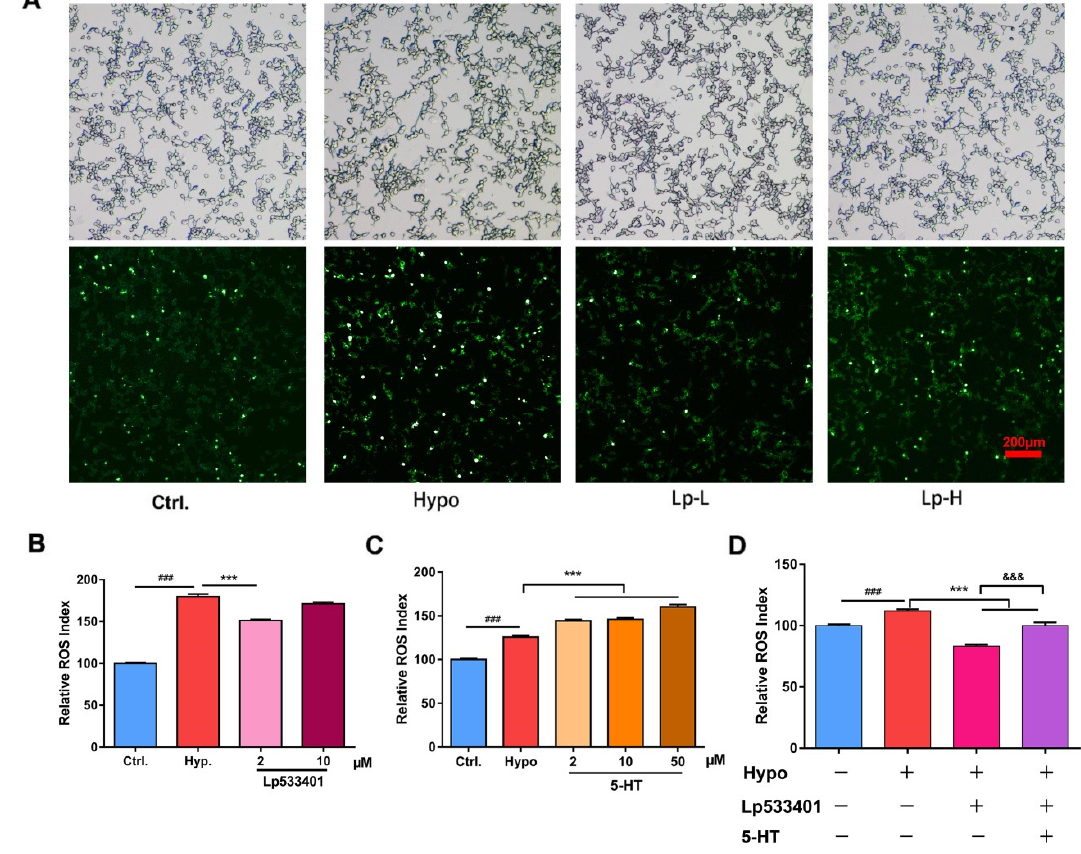
Figure 4. The 5-HT metabolism pathway influenced the ROS generation in RIN-14B cells. ( A ) Cells were stained with DCFH-DA and were observed under a fluorescence microscope. Representative fluorescence images showed the ROS level in RIN-14B cells compared to the control after exposure to 5% O 2 for 48 h. (Lp-L: 2 µ M, Lp-H: 10 µ M; Scale bar: 200 µ m). ROS were detected with ROS assay kit after treated with ( B ) LP533401, ( C ) 5-HT, and ( D ) both. "+", the sample treated with the corresponding condition or the agents at certain concentrations, and “ − ”, untreated. ( n = 6 each group). ### P < 0.001 represent compared with control, *** P < 0.001 represent compared with model (hypoxia), &&& P < 0.001 represent compared with the LP533401 treated group. P < 0.05 was considered as statistically significant, calculated by ANOVA.